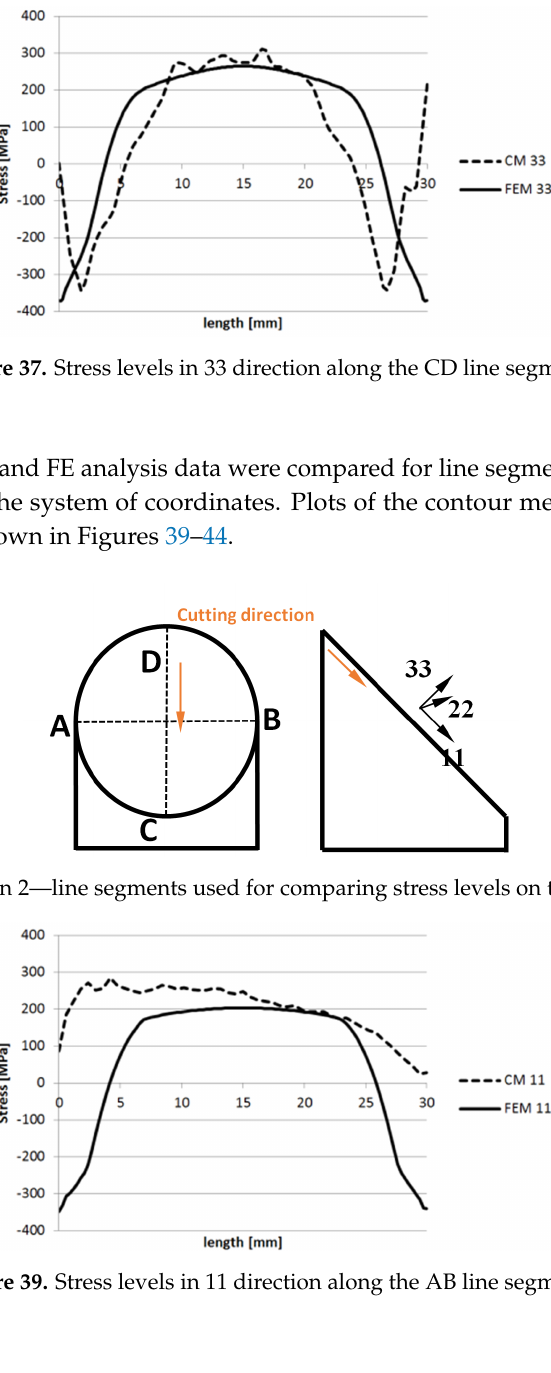
Figure 36. Stress levels in 33 direction along the AB line segment.